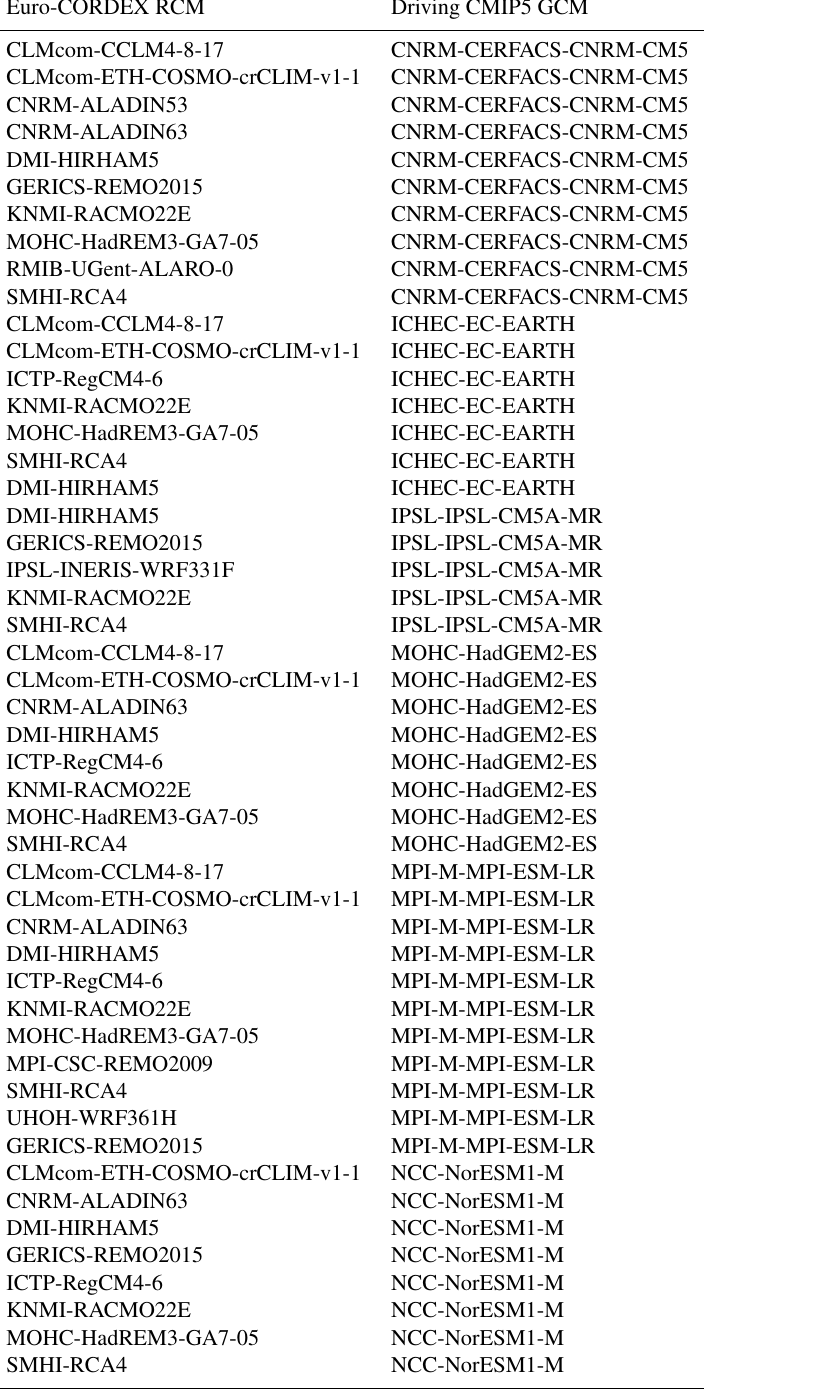
Table A1. List of EURO-CORDEX models used, with their driving GCM (49 RCM–GCM pairs in